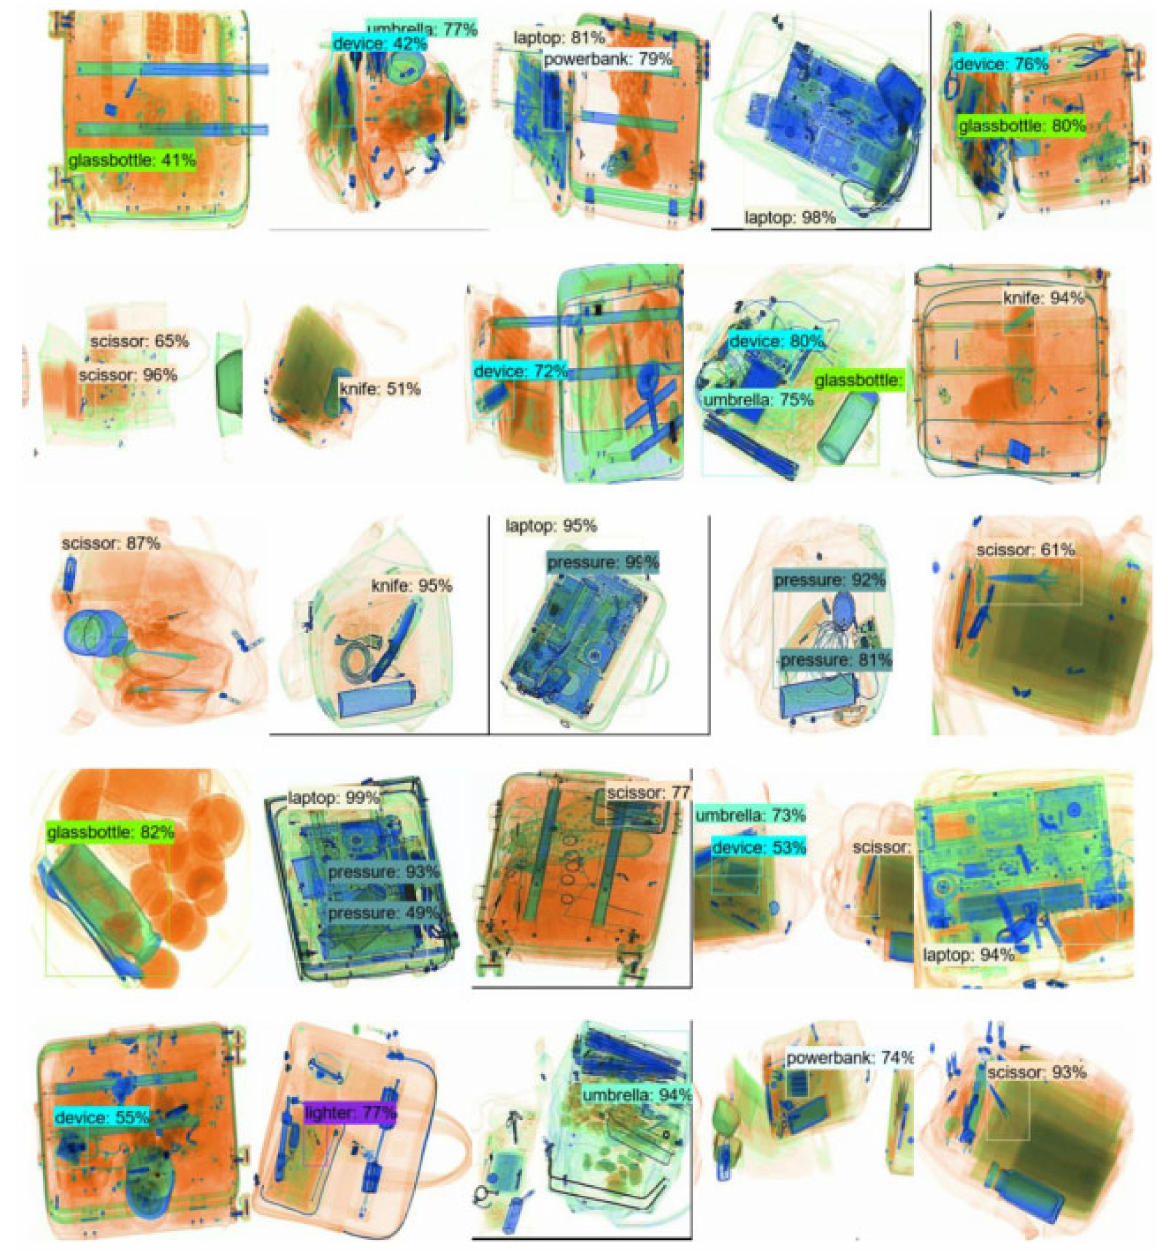
Figure 13. Prediction